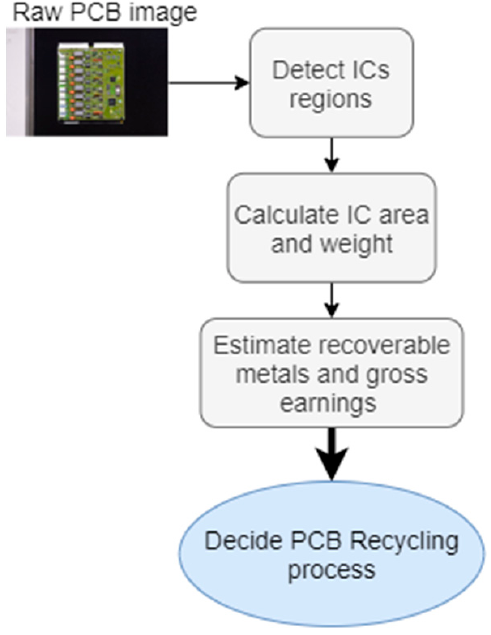
Figure 1. Diagram of the proposed method evaluation.